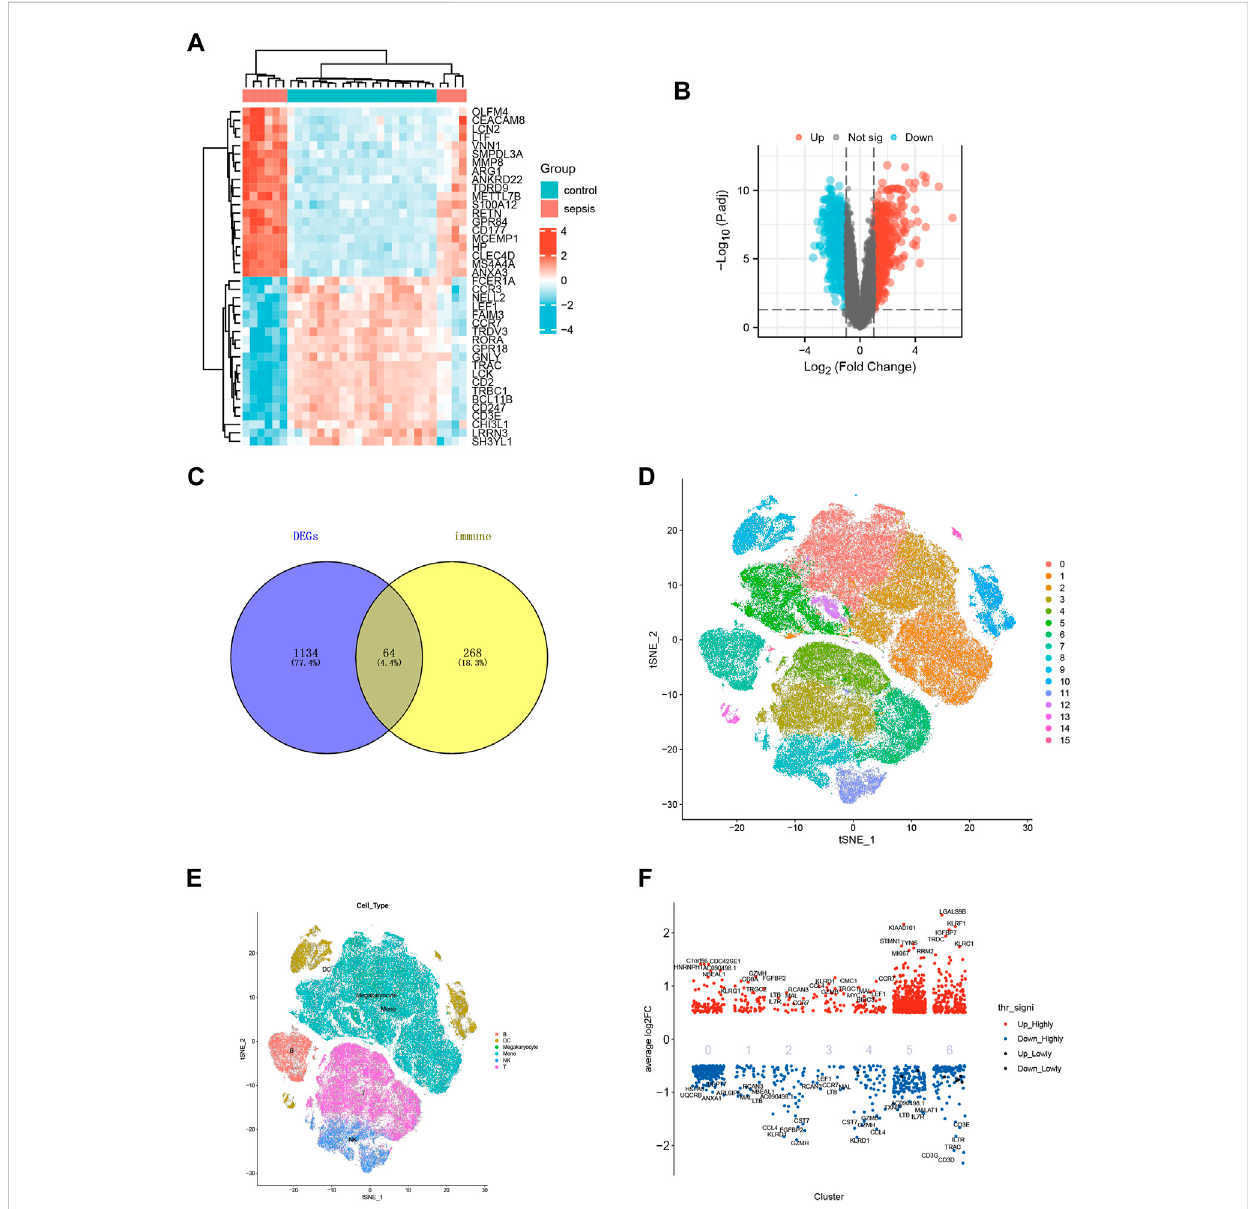
FIGURE 2 Data standardization and immune-related gene screening. (A) Heat map for GSE28750. Blue represents the control group and red represents the sepsis-induced lung injury (SILI) group. (B) Volcano map for GSE10474. Red represents upregulated differential genes, blue downregulated differential genes,andblackrepresentsundifferentiatedgenes. (C) Venndiagramshowingintersectionfordifferentialgenesofsepsisandimmune-relatedgenes. (D) tSNEdiagram for single cell samples ofsepsis. 0 – 15representingdifferentcell clusters. (E) tSNEdiagramfor single cell sampleswith differentcolors representingTcells,Bcells,Monocells,Megakaryocytecells,NKcells,andDCcellsrespectively. (F) Singlecellheatmapofdifferentiallyexpressedgenes, with red representing highly expressed genes and blue representing low-expressed